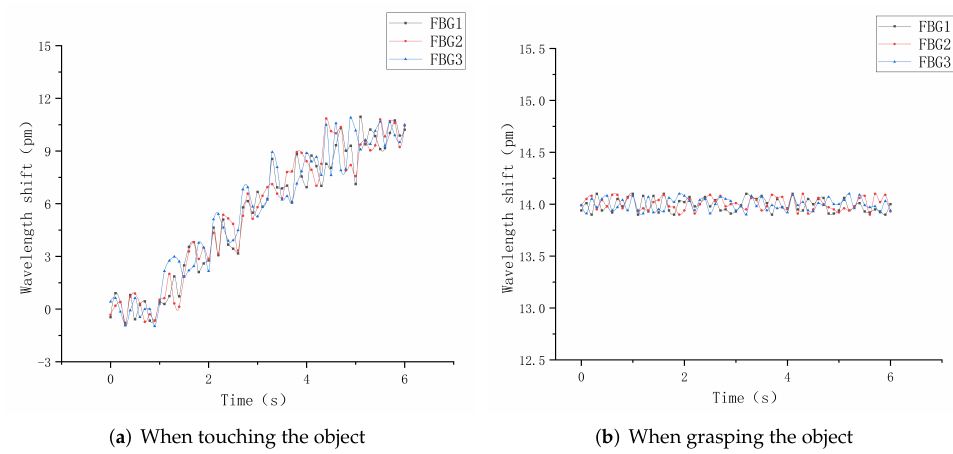
Figure 31. Slip response